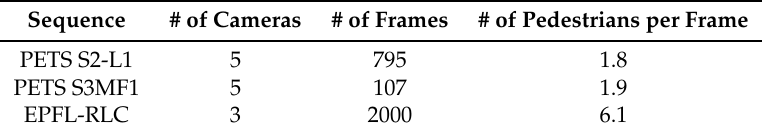
Table 1. Description of the experimental